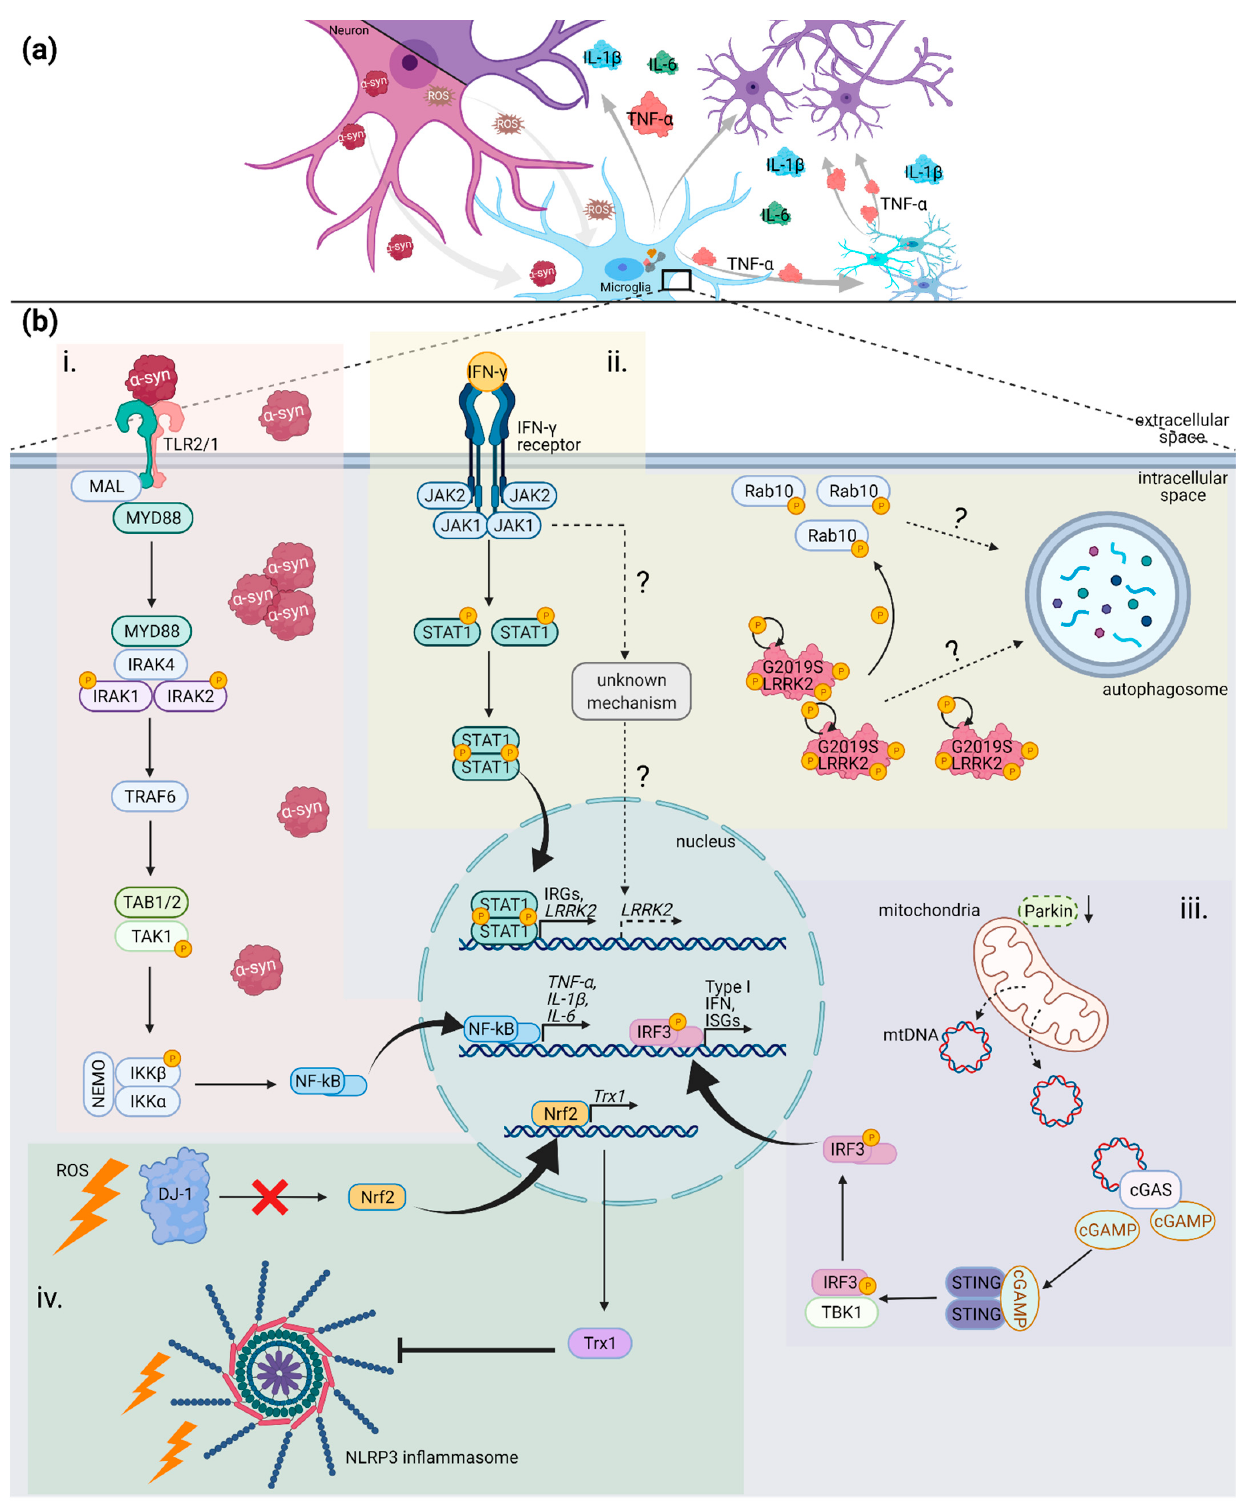
Figure 2. Neuron-microglia cross talk and selected inflammatory pathways involved in PD. ( a ) Inflammatory loop initiated by neuronal demise and propagated by microglial dysfunction. ( b ) Inflammatory pathways associated with α -synuclein (i), LRRK2 (ii), parkin (iii) or DJ-1 (iv) in the context of PD pathology. This figure was created with